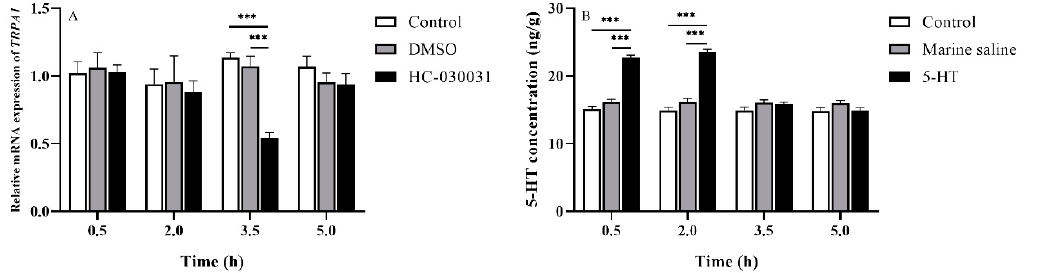
Figure 2. ( A ) TRPA1 expression in the gut of Strongylocentrotus intermedius after the HC-030031 in- jection ( n = 5). ( B ) The 5-HT level in the gut of S. intermedius after the 5-HT injection. The symbol *** means p < 0.001 ( n = 5, mean ± s.e.m.).